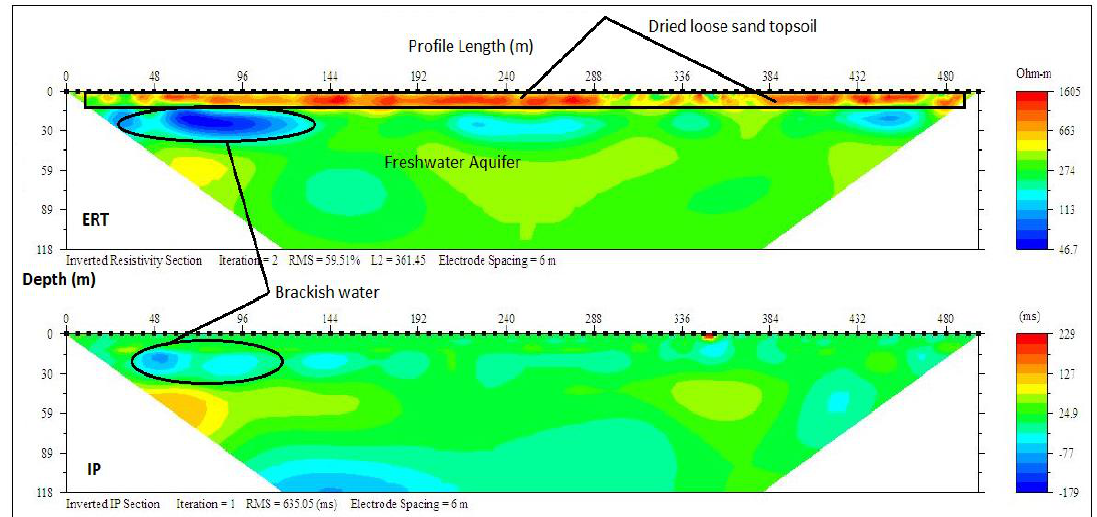
Figure 13. Inverted resistivity and IP cross-sections Lakowe (Profile section P9).